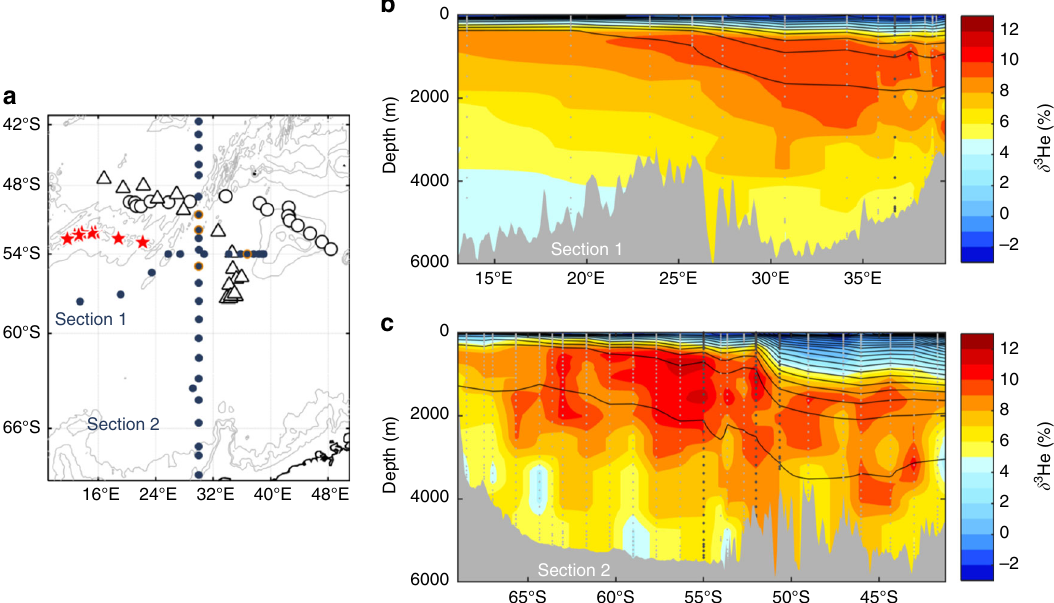
Fig. 3 Hydrothermally in fl uenced deep waters along the SWIR. Map ( a ) showing the locations of the bathymetry of the SWIR (contour levels: 2000, 3000, and 4000 m), the hydrothermal vents (red stars), the two BGC-Argo fl oats (black triangle dots: fl oat WMO 6901585 and black circle dots: fl oat WMO 2902130), and of the two sections ( fi lled blue circle dots; b and c ) of interpolated δ 3 He. Note that all the vertical δ 3 He pro fi les, where the surface eddy kinetic energy is high (EKE; >150 cm 2 s − 2 ), have been highlighted by additional orange circle dots in a and by darker gray in b and c NATURE COMMUNICATIONS| (2019) 10:2451